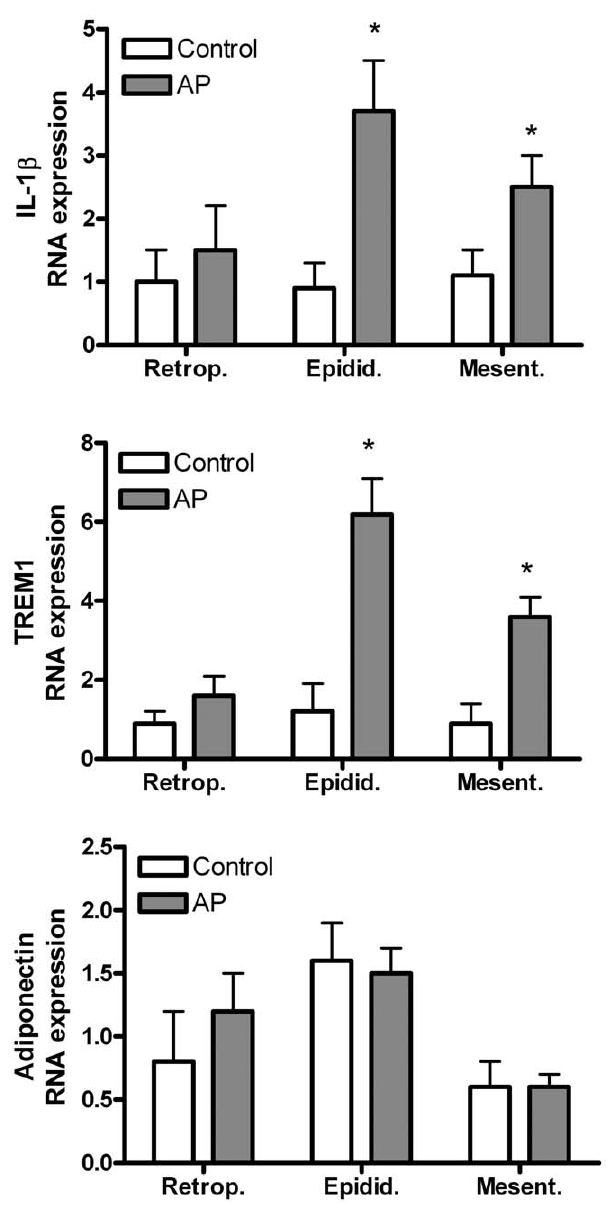
Figure 4. RNA expression of IL1 b and TREM1 were induced by acute pancreatitis in epididymal and mesenteric adipose tissues while no changes were observed in retroperitoneal adipose tissue. Adiponectin expression was not induced in any of the three areas of adipose tissue evaluated. * = p , 0.05 vs control.